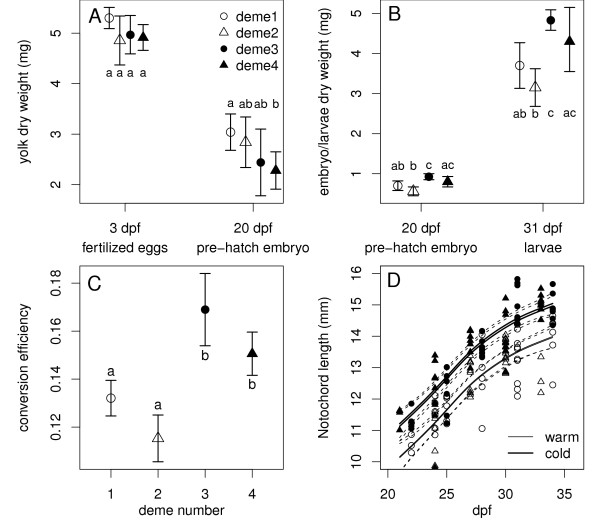
Growth trajectories and yolk-to-body mass conversion efficiencies. Mean (± 95% confidence intervals) dry weights of total embryo, yolk sac and hatchlings at 3, 20 and 31 days post fertilisation (DPF) A. rate of yolk absorption, B. rate of embryo and hatchling growth. Similar letters indicate demes that have non-significant differences in conversion efficiencies (Tukey-Kramer HSD pairwise contrast tests). C. Mean (± 95% confidence intervals) yolk-to-body mass conversion efficiency of grayling embryos from warm and cold demes raised under similar conditions (8°C). The conversion efficiency was estimated as the ratio of embryo dry weight at 20 DPF on egg dry weight at 3 DPF. Similar letters indicate demes that have non-significant differences in conversion efficiencies (pair-wise t-tests). D. Notochord length-at-age for warm and cold deme post-hatch grayling larvae raised under similar conditions (8°C). Lines correspond to the GAM-predicted growth trajectories for each deme (see Additional file 2). Dashed lines correspond to 95% confidence bounds. The GAM explained 77% of the variation (group effect: F1,144 = 803, P << 0.0001).